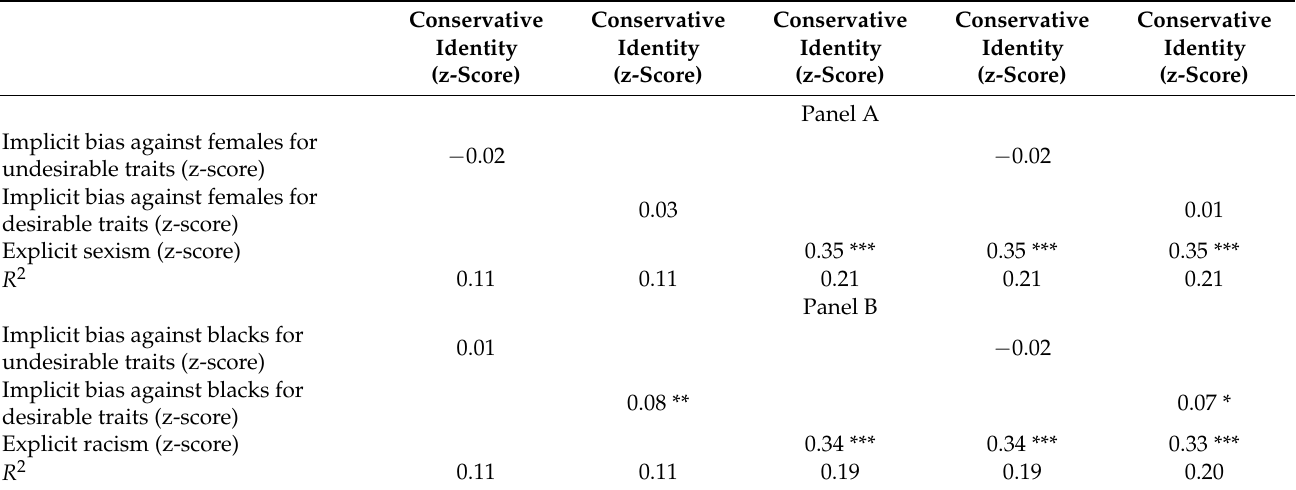
Table 2. OLS models comparing the effects of implicit bias and explicit prejudice on conservative